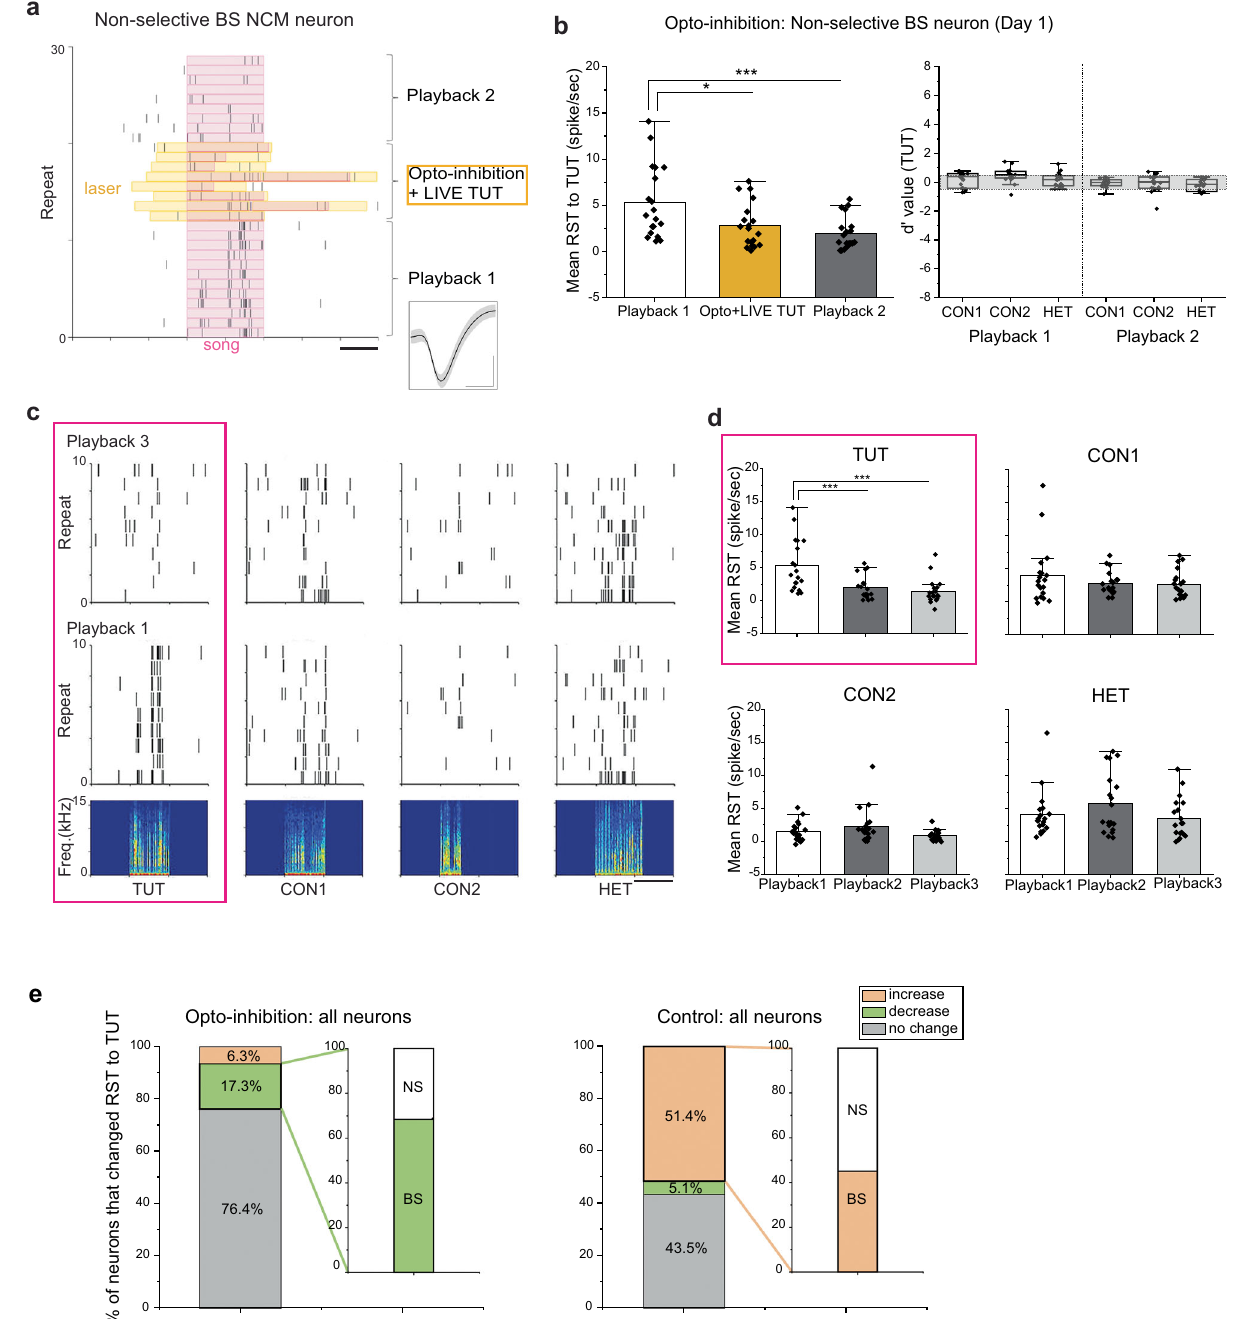
Fig. 4 | Inhibition of LC neuronal activity during social interaction with a singingtutordiminishesauditoryresponsestothetutorsonginasubsetofBS NCMneurons.a , c Rasterplotsofspikingactivityinanon-selectiveBSNCMneuron totutorsongplayback1and 2,ortutorsinging withoptogeneticinactivationof LC inputs (Opto+LIVE TUT)( a , scale bar:1s) or to playbacks of different songs before (playback 1) and after (playback 3) Opto+LIVE TUT ( c , scale bar: 2s, song spec- trogramsshowninthebottom).Inset:spikewaveformofthesamenon-selectiveBS neuron( a ,mean±s.d.,scalebars:0.5mshorizontal,0.5mVvertical). b Left, d